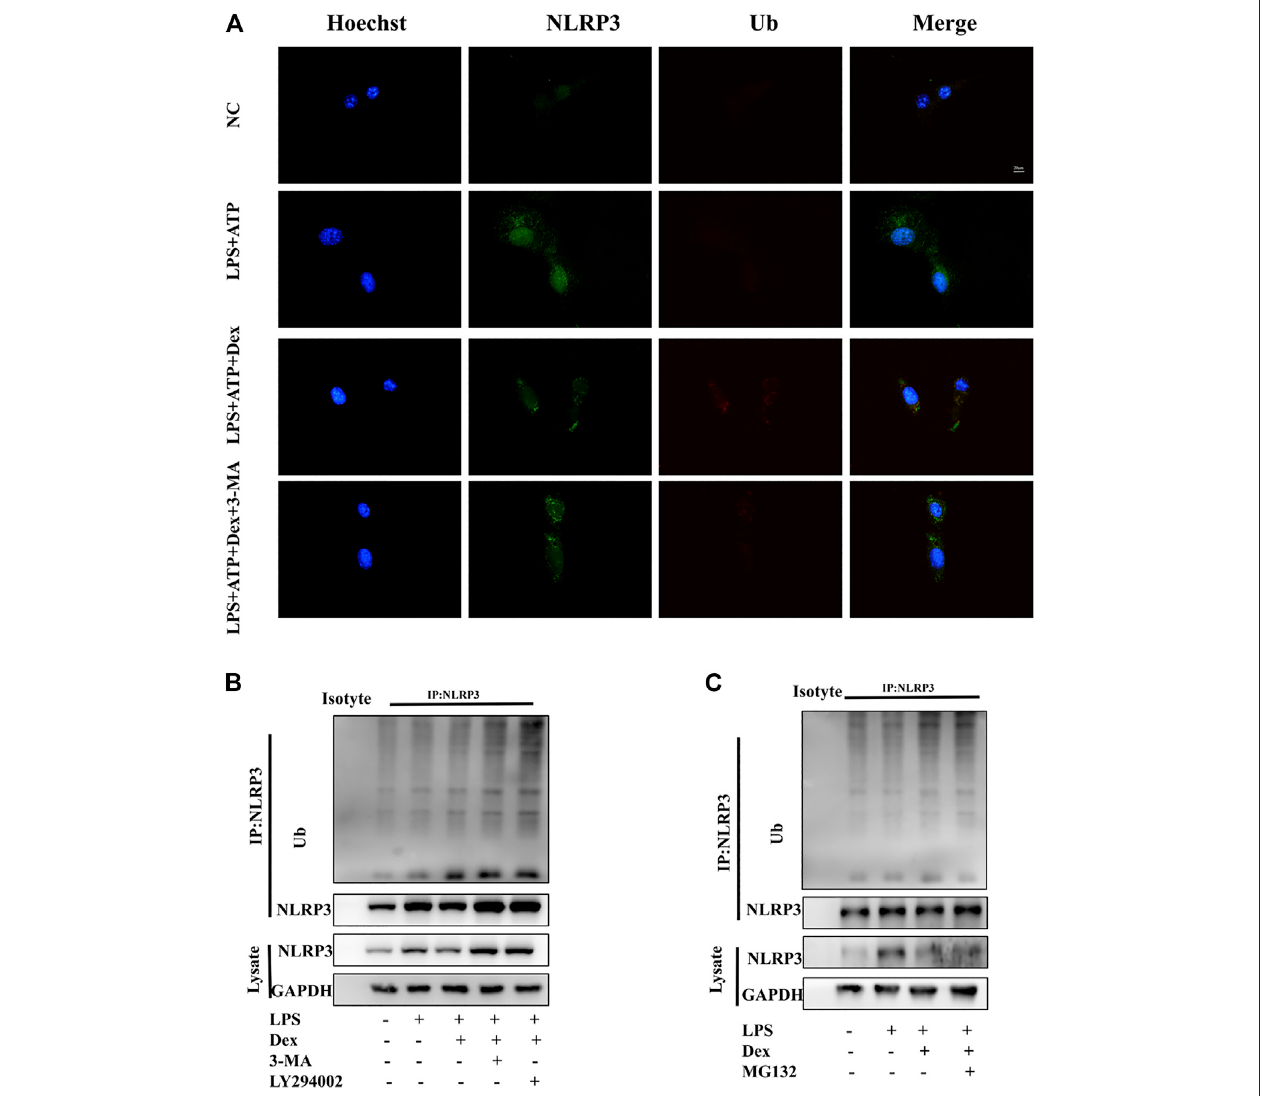
FIGURE 6 | DEX promoting ubiquitination-mediated degradation of NLRP3. DEX promoted ubiquitination-mediated degradation of NLRP3. (A) Primary microglia cells were treated the same way as before. Cells were analyzed by NLRP3 and ubiquitin immuno fl uorescence. Scale bar (cid:1) 20 μ m. LPS-primed primary microglial were cultured with MG-132 (10 μ M), 3-MA (5 mM) or, LY294002 (10 µM) for 1 h and then treated with DEX (10 μ M) for 5 h. Immunoblotting analysis of Ub protein level in cell lysates immunoprecipitated with NLRP3 antibody (B,C) .